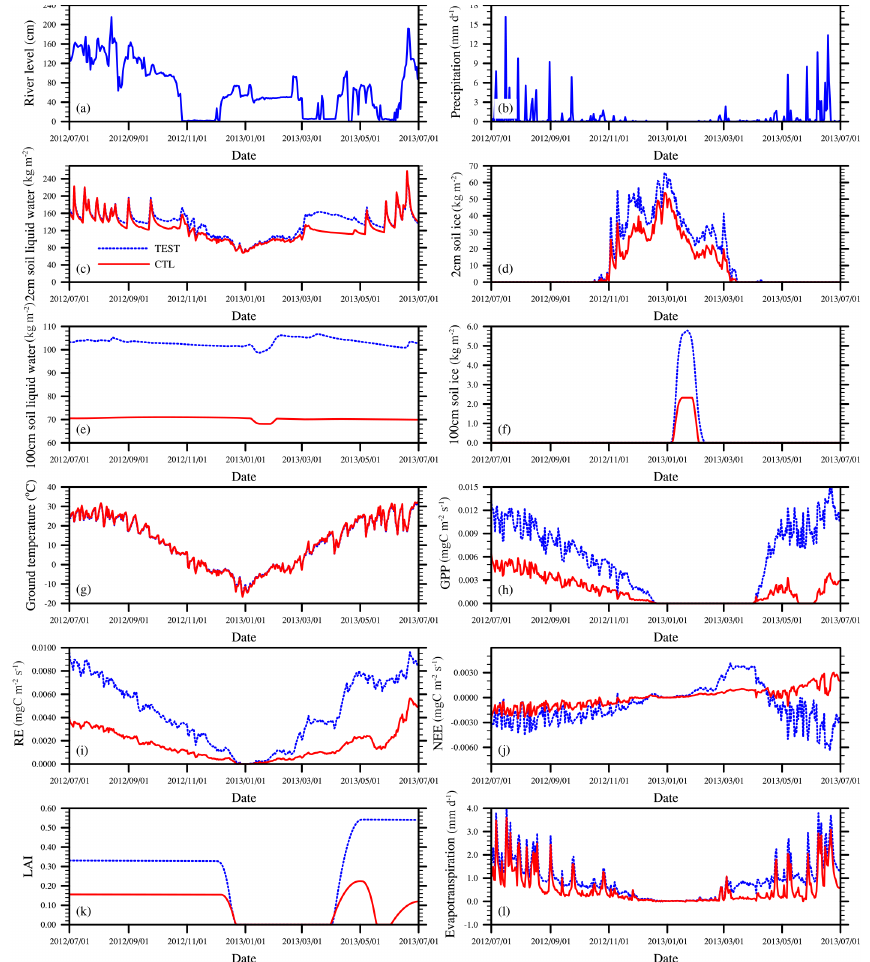
Figure 12. Time series of area-averaged daily (a) observed river level and (b) observed precipitation, as well as (c) 2cm soil liquid water, (d) 2cm soil ice, (e) 100cm soil liquid water, (f) 100cm soil ice, (g) ground temperature, (h) gross primary productivity, (i) respiration efficiency, (j) net ecosystem exchange, (k) leaf area index, and (l) evapotranspiration predicted by TEST and CTL simulations within 300m of both sides of the stream at the 213 Bridge